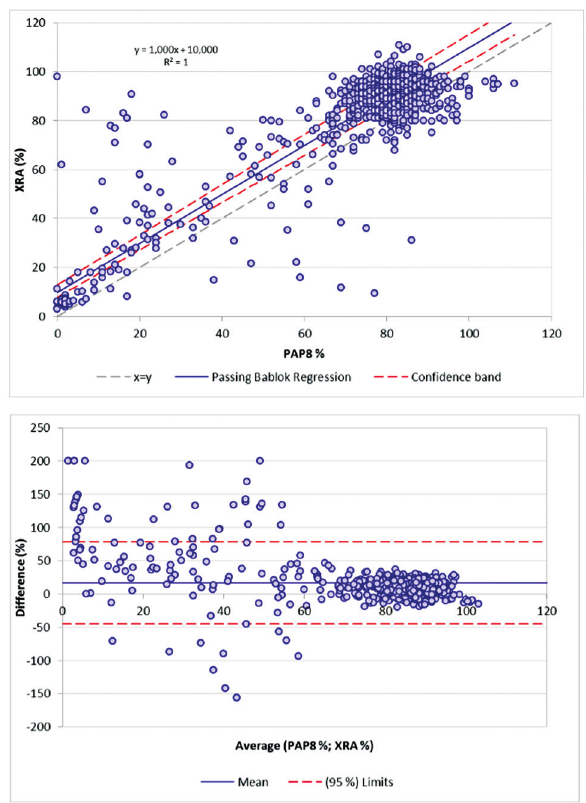
Fig. 4 Method comparison using MA% for n ¼ 47 patients and n ¼ 100 healthy individuals tested on TXRA against PAP-8 with identical reagents. ( A ) Passing – Bablok analysis and ( B ) Bland – Altman plot. Data represent 1,029 individual results from healthy controls ( n ¼ 100, seven reagents) and 47 patients ( n ¼ 47, seven reagents).